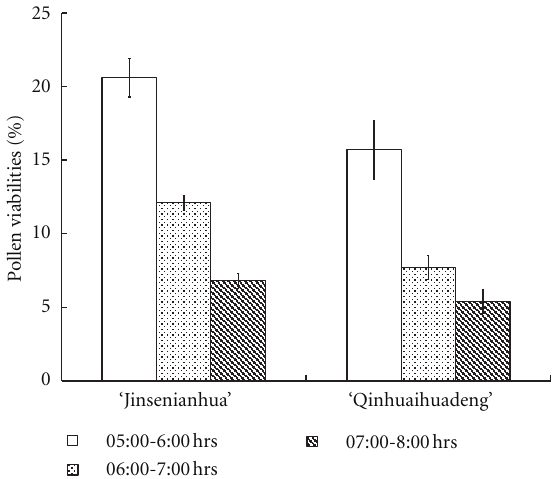
Figure 1: Viabilities of pollen grains collected at di ff erent times.